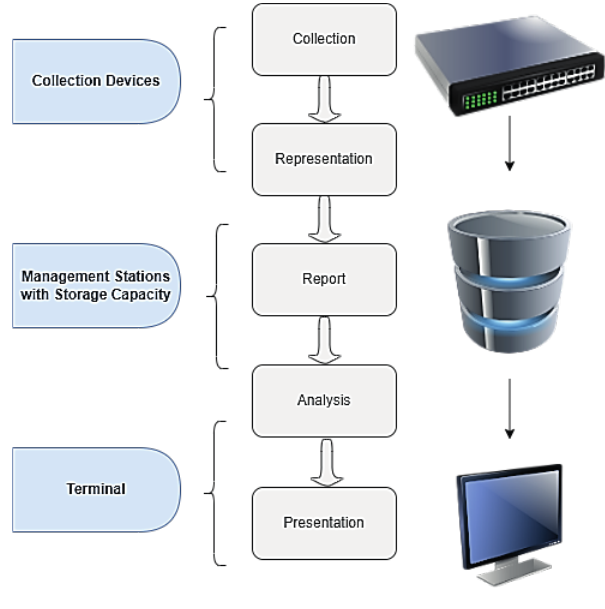
Fig. 1. Sub-classification of monitoring